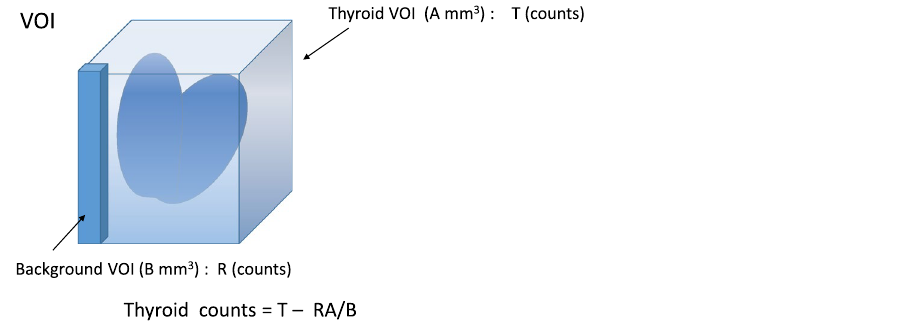
Figure 1. The thyroid gland and background regions were obtained in each slice of the single-photon emission computed tomography (SPECT) image, and by summation, the count value was obtained as a three-dimensional volume of interest (VOI). Thyroid counts = T − RA/B; Thyroid VOI (A mm 3 ), T (counts), background VOI (B mm 3 ), R